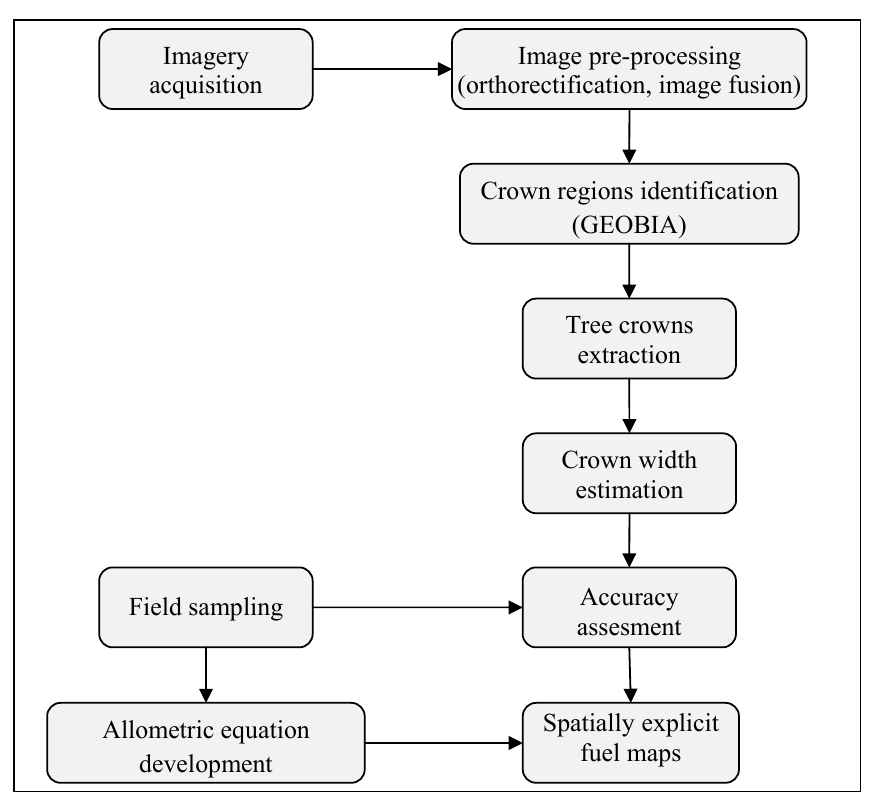
Figure 1. Flowchart of the overall methodological